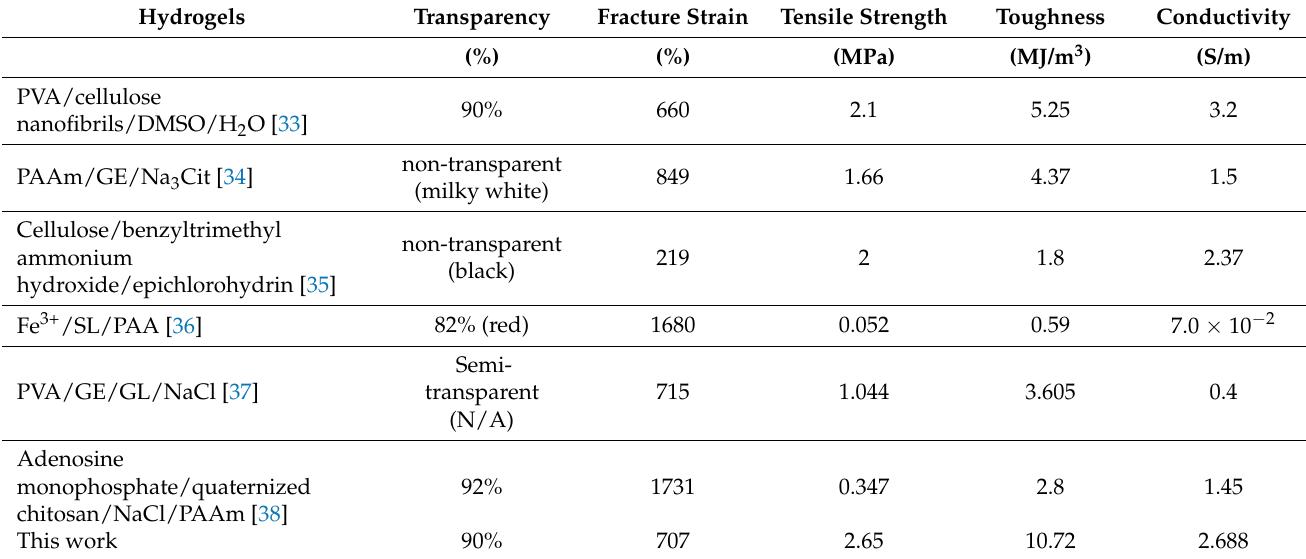
Table 1. Brief summary of results reported on conductive